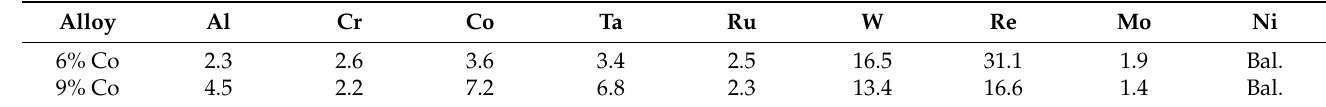
Table 2. Chemical components of the TCP phase in the 6% Co alloy and 9% Co alloy after aging 1000 h at 1100 °C (wt%).